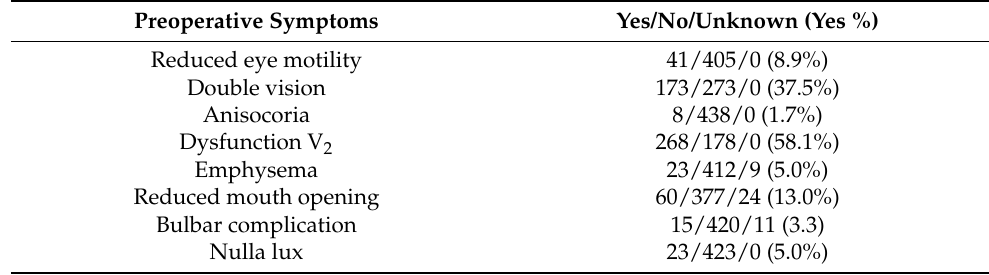
Table 5. Preoperative clinical findings in 446 cases of isolated unilateral zygomatico-orbital